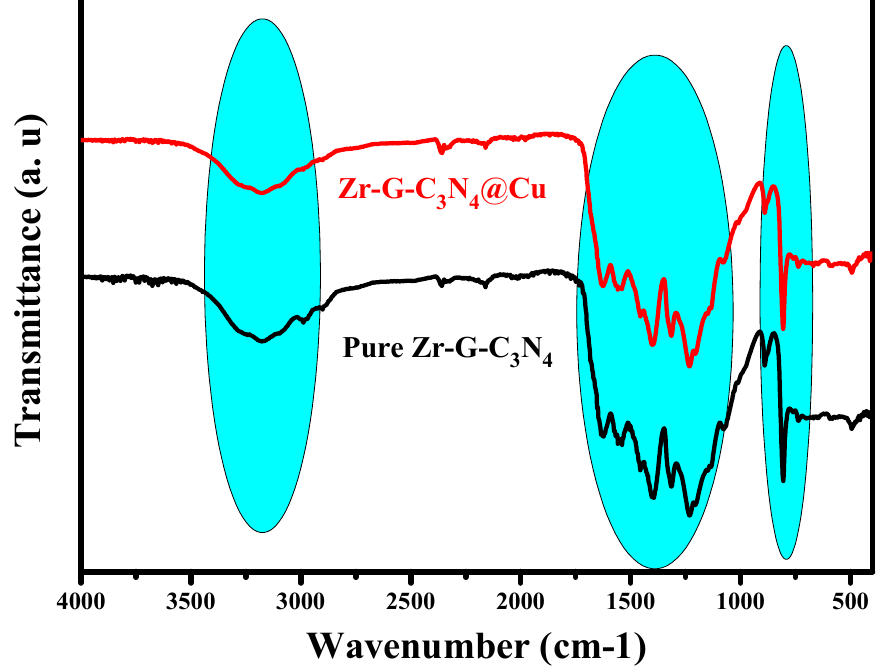
Figure 6. FTIR spectra before and after Cu 2+ adsorption onto the surface of Zr-G-C 3 N 4